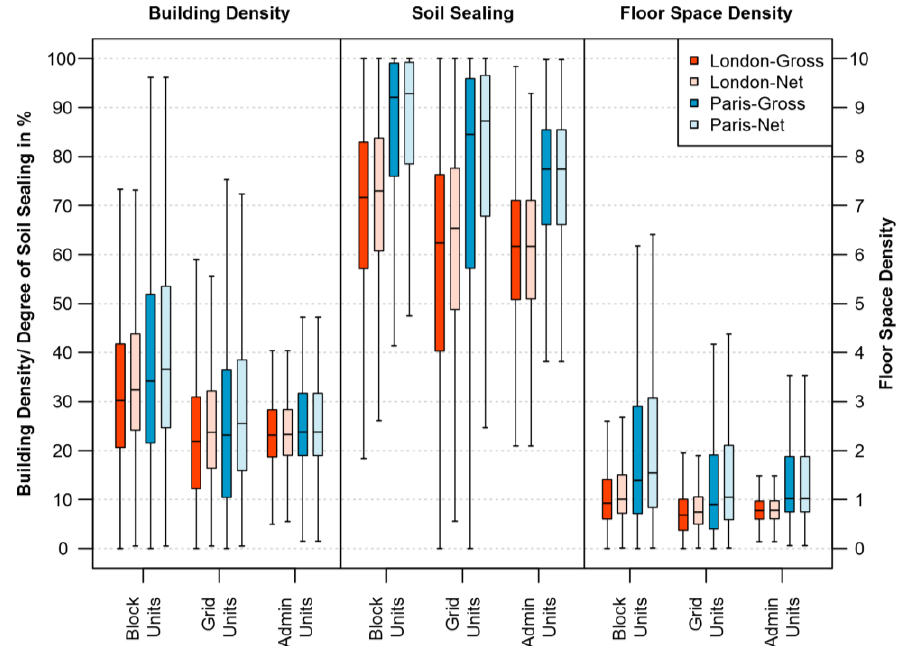
Figure 6. Density measures illustrated as boxplots for three thematic dimensions—building density, soil sealing, and floor space density—and the influence of the reference units—administrative, grid and block units—calculated for gross and net densities at city scale for Paris and London. ISPRS Int. J. Geo-Inf. 2016 , 5 , 206